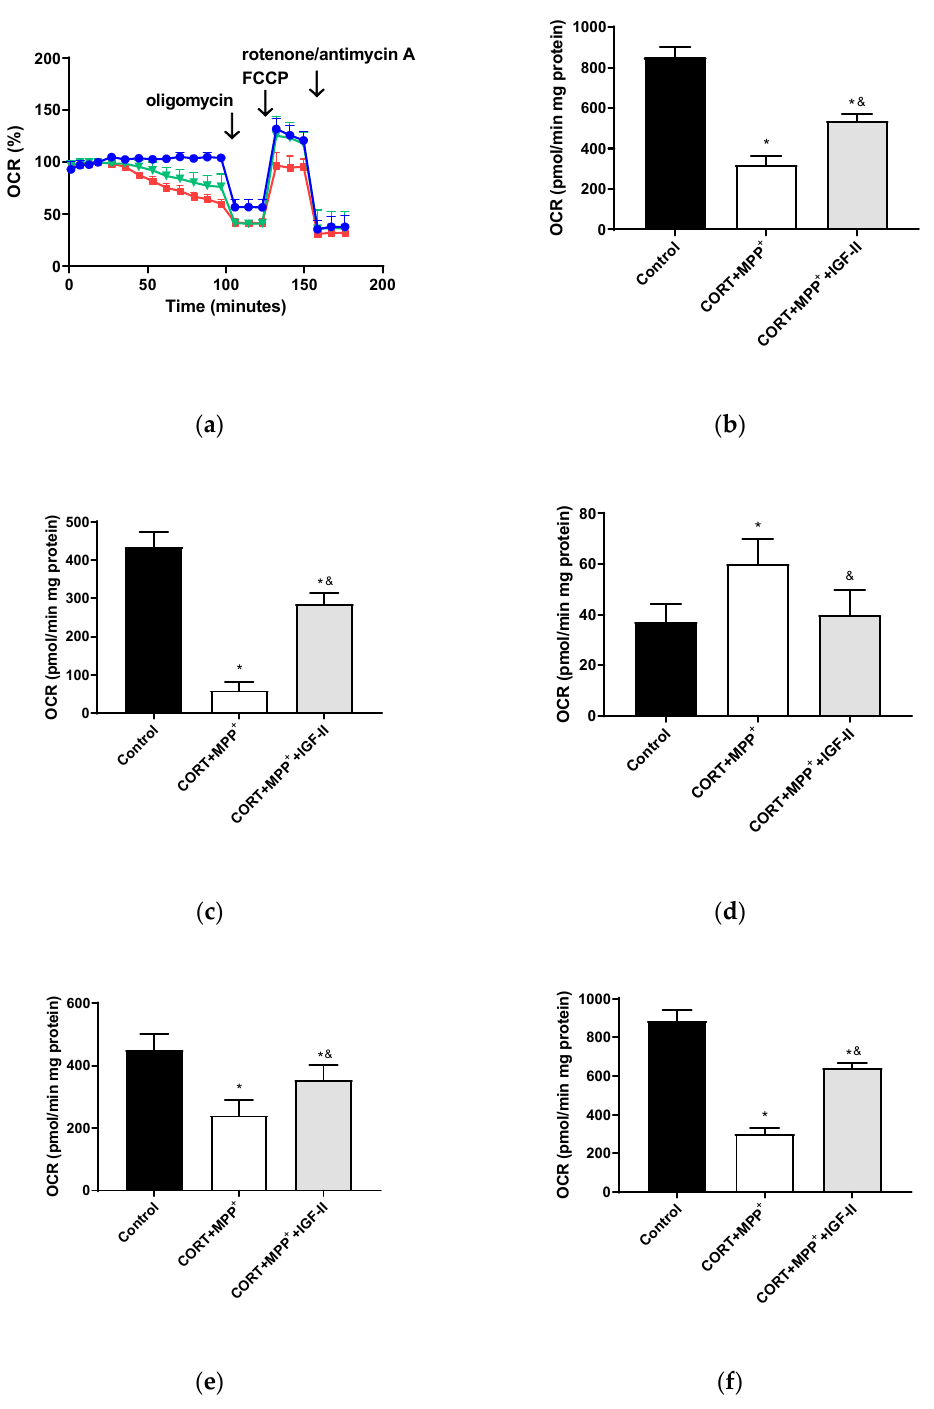
Figure 4. Study of the mitochondrial oxygen consumption rate (OCR) in SN4741 neuronal cells after 90 min of incubation with the combination of corticosterone and MPP + (CORT + MPP + ) in the presence or absence of IGF-II. ( a ) Representative experiment of the measurement of key parameters using the Mito Stress test kit. Blue line: control; green line: presence of IGF-II; red line: combination of the two drugs (CORT + MPP + ); ( b ) basal consumption after 90 min of incubation; ( c ) ATP production; ( d ) proton leak; ( e ) spare respiratory capacity; ( f ) maximal respiration. Data from six to eight independent experiments were combined and presented as mean ± SEM. * p < 0.05 compared to control cells; & p < 0.05 compared to CORT + MPP + co-incubated cells.